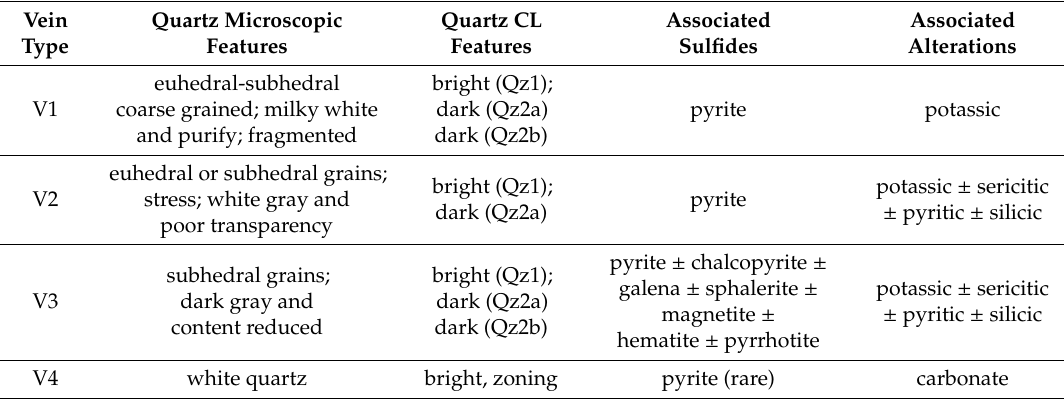
Table 1. Characteristics of vein types of the Linglong gold